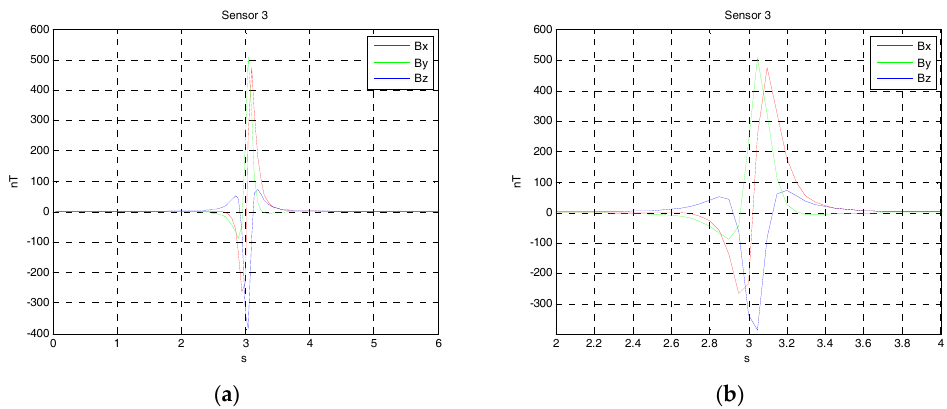
Figure 7. ( a ) The three components alternating magnetic field data acquire by sensor 3 from the time of 0 s to 6 s; ( b ) The three components alternating magnetic field data acquire by sensor 3 from the time of 2 s to 4 s.